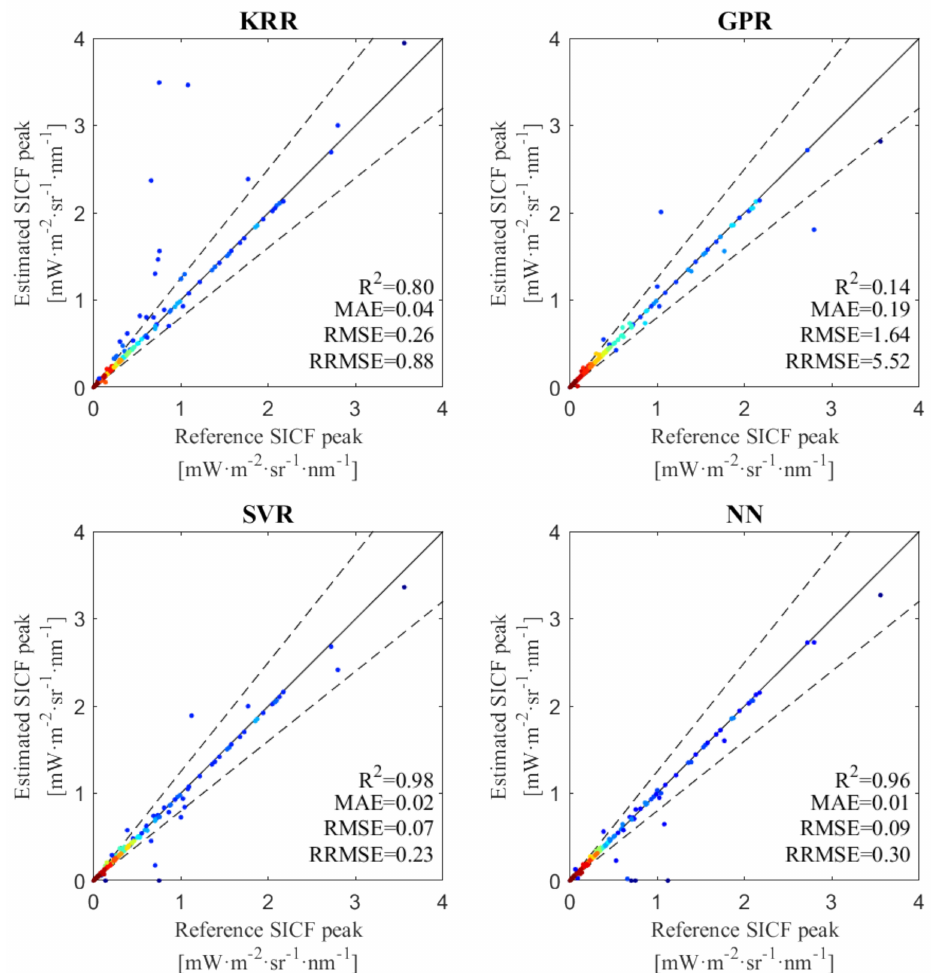
Figure 10. Scatterplot of reference SICF peak vs. estimated SICF peak (at 685 nm) for each MLRA retrieval method used to estimate the intermediate Rrsn − SICF ( λ ) . The color dots correspond to the density of samples, the red zones being higher and the blue zones lower. The dashed line corresponds to the limit of 20% of